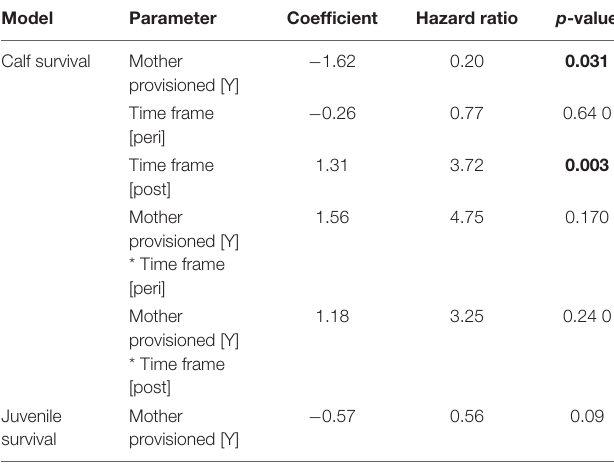
TABLE 3 | Cox proportional hazards mixed effect models for calf and juvenile survival.